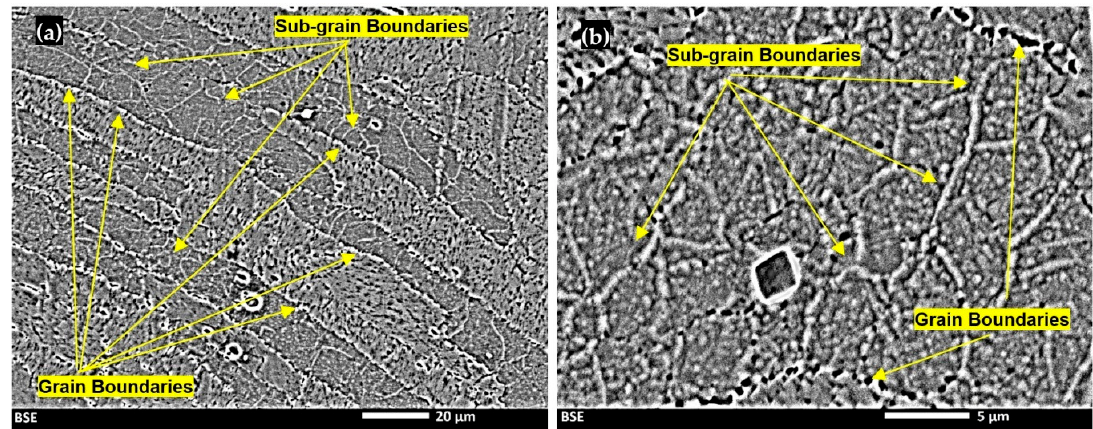
Figure 9. SEM analysis of the flow arm shaped branches at the RS. ( a ) A bunch of elongated grains at the position of the flow pattern, ( b ) higher magnification of the inside of the grain, representative of the high density of the sub-grain boundaries as a response to the stored strained during the DRX.